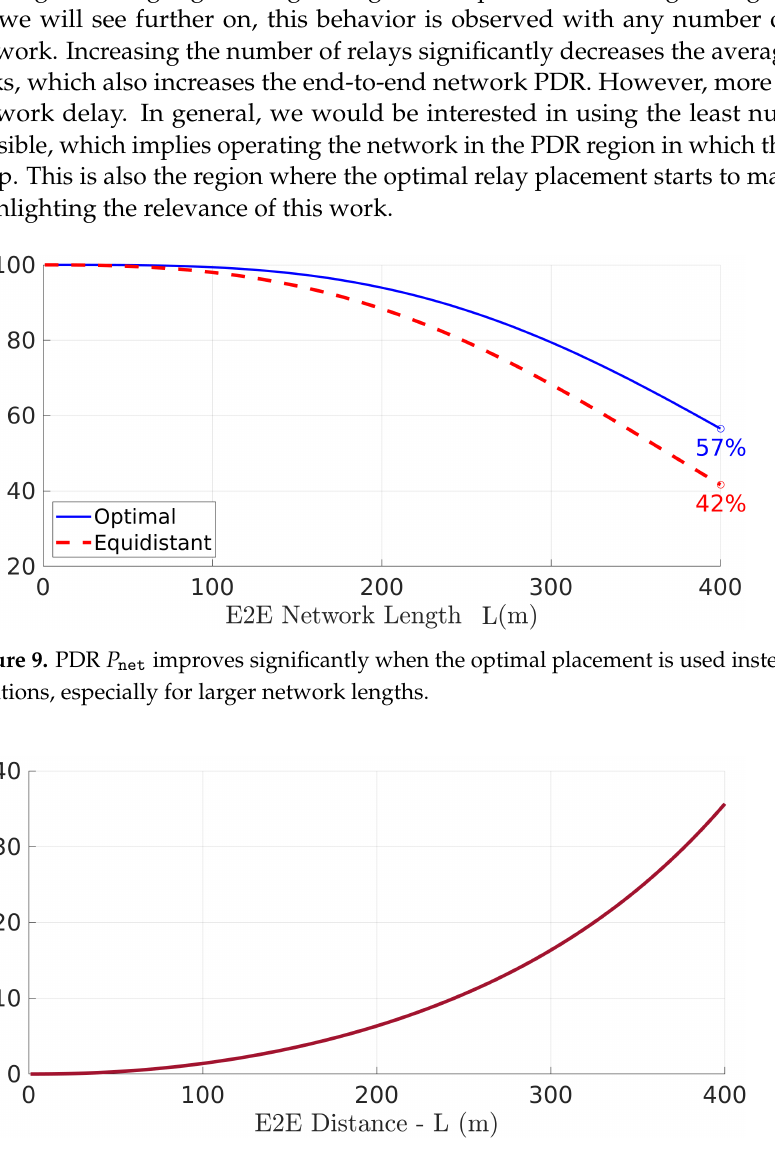
Figure 10. PDR P net relative gain ( Φ ) using the optimal placement with respect to equidistant